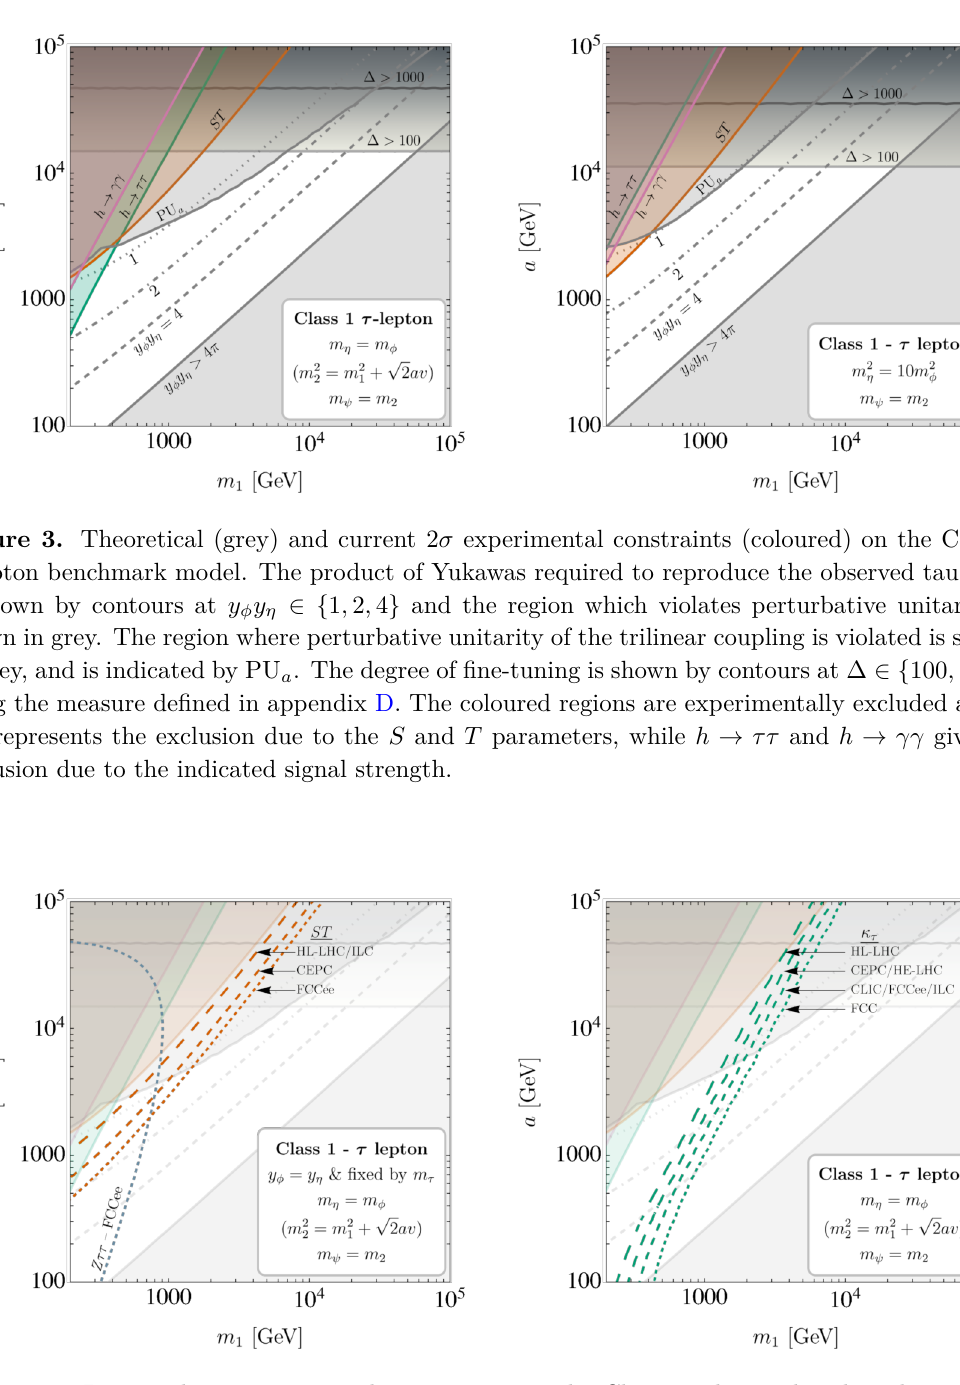
Figure 4. Projected 2 σ experimental sensitivities on the Class 1 τ -lepton benchmark model at future colliders for the left hand slice in fig. 3. For the Zττ sensitivity we have assumed y χ = y ψ and fixed the values to reproduce the tau mass. See appendices A and E for details of the kappa framework and our assumptions for the running scenarios of future collider experiments. Where future colliders have comparable sensitivity, we show a single curve for